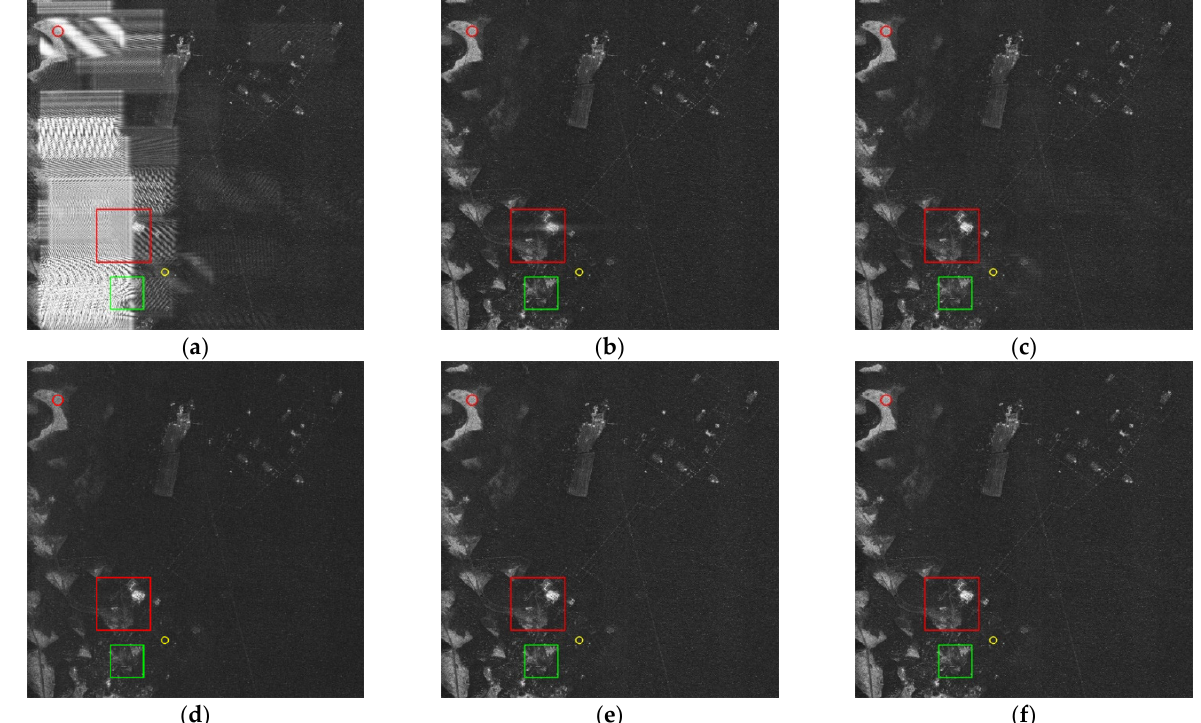
Figure 20. Resulting SAR image after applying ( a ) the SAR imaging algorithm applied directly without interference mitigation, ( b ) ISNF, ( c ) ESP, ( d ) GoDec, ( e ) LRDS, and ( f ) TFC-LRS.